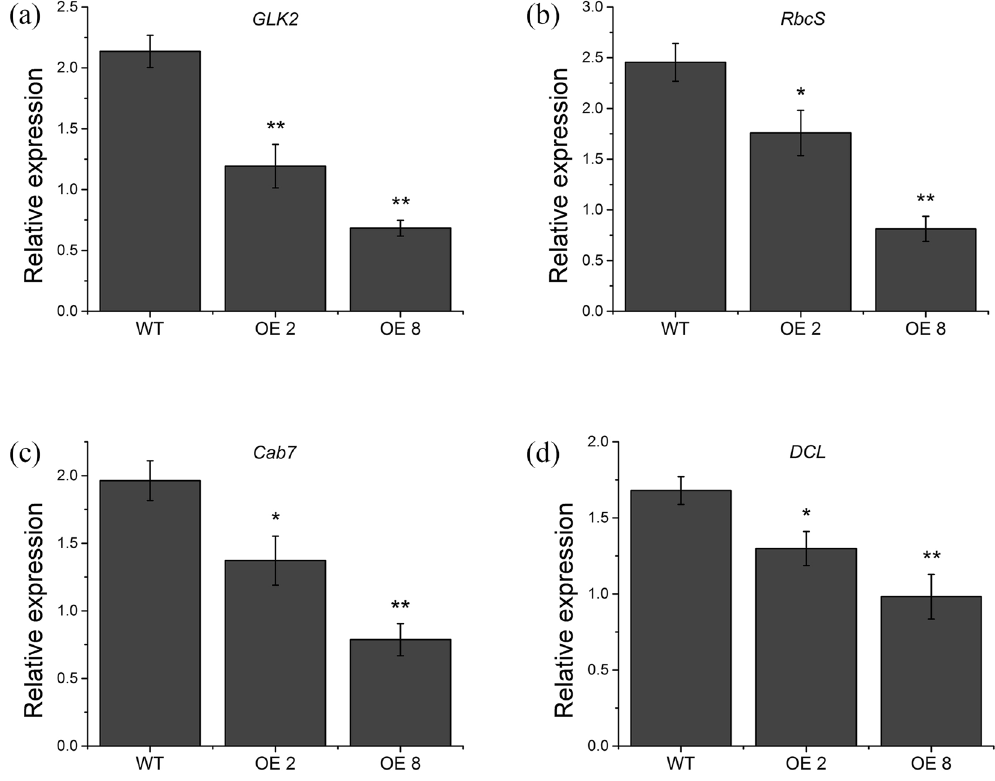
Figure 3. Expression levels of GLK2 , RbcS , Cab7 , and DCL in mature leaves of wild type and 35 S:PRE2 lines. Data are the mean ± SD of three biological replicates. * Significantly different from the wild type, P < 0.05; ** for P <